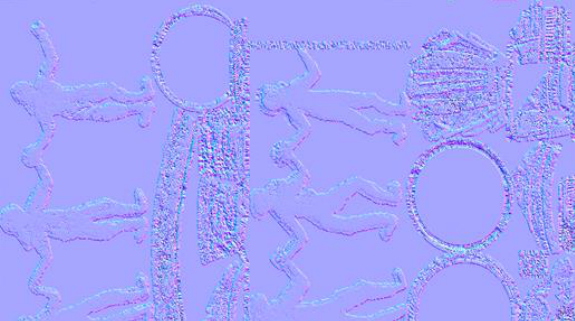
Figure 6: Krater case study. Baking Normal Map, partial